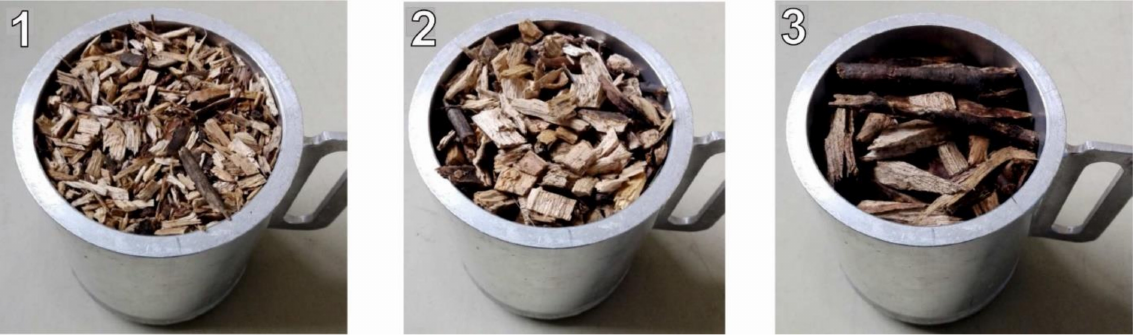
Figure 5. Individual fractions of forest wood chips after screen analysis, placed into the measuring cylinder for wood chip volume measurement. ( 1 )—less than 10 mm, ( 2 )—10 to 18 mm, ( 3 )—larger than 18